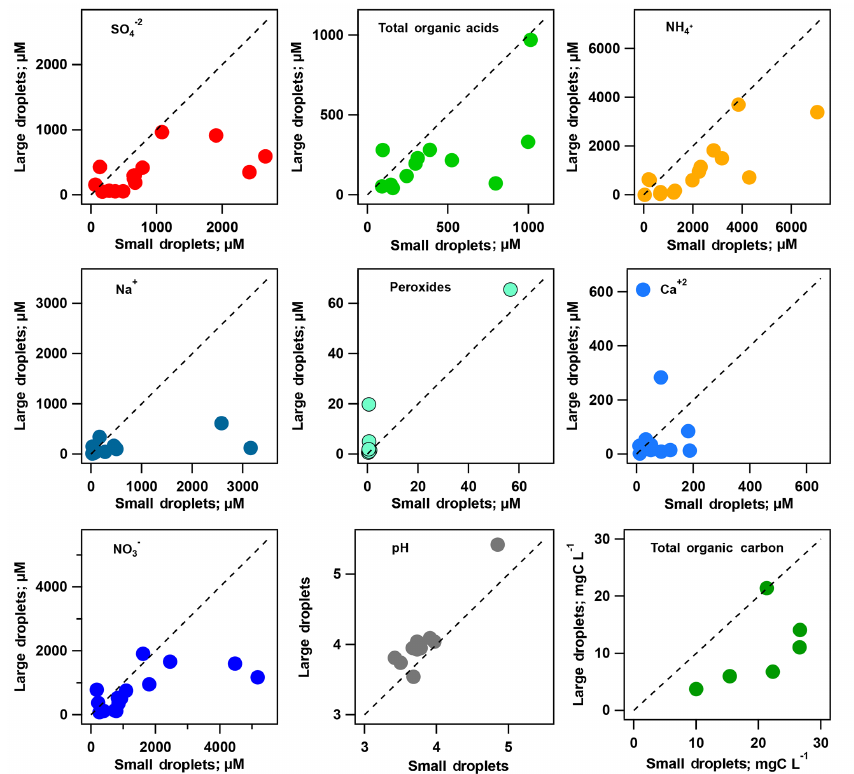
Figure 8. Scatter plots showing size distribution of major species in BYI fog water samples. All species shown, with the exception of peroxides, were enriched in small